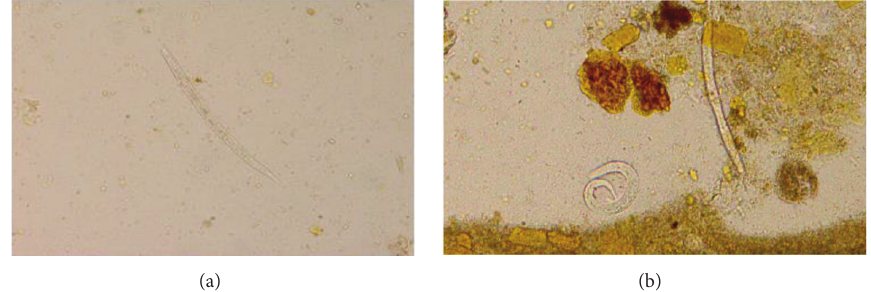
Figure 4: (a) Strongyloides stercoralis larva isolated from stool. (b) shows two Strongyloides stercoralis larvae in stool